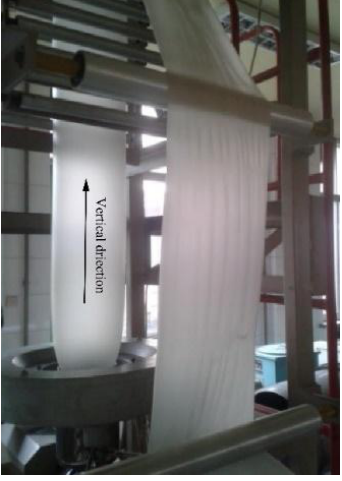
Figure 3. Continuous and stable blowing of HPDSP-OMMT film.